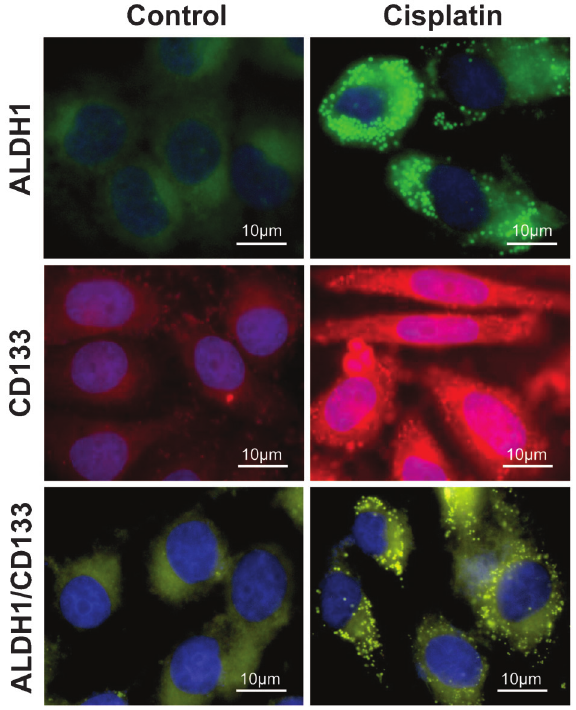
Figure 3. Immunocytochemical analysis of ALDH1++ and CD133++ cells. HepG2 cells were treated with 4 m g/mL cisplatin. Forty-eight hours after drug treatment, cells were stained with anti-ALDH1-FITC (upper panels) or anti-CD133-PE (middle panels). Bottom panels are merged data. Nuclei were labeled with propidium iodide